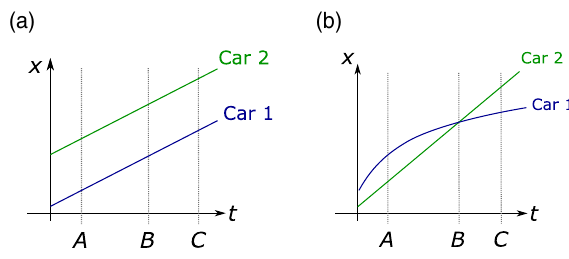
FIG. 1. Diagrams given to students as part of a study reported in Ref. [5]. The graph shown in (b) was used in the kinematics graph task (Experiments 1A and 1B) for the current work. (In the original work, the diagrams were black and